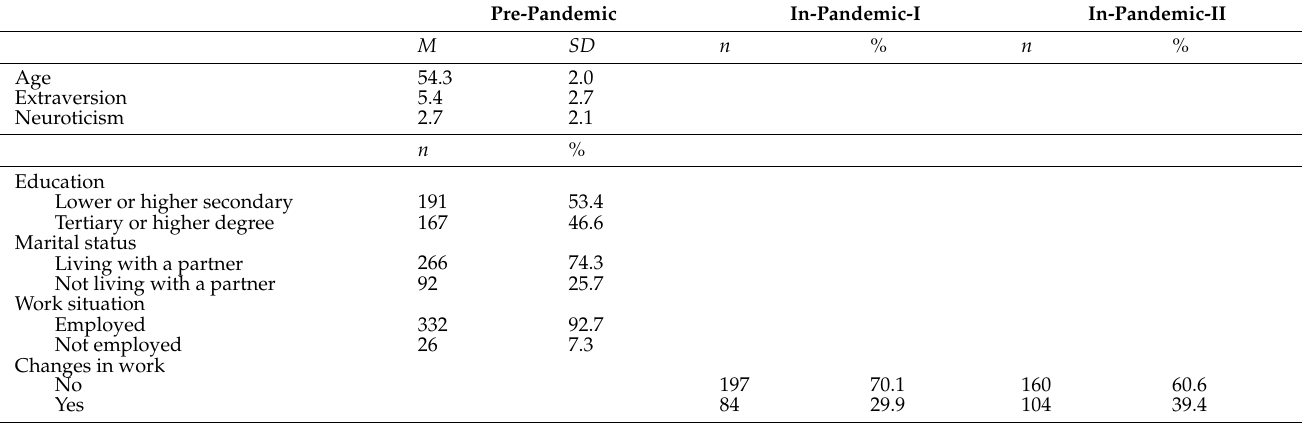
Table 1. Descriptive statistics at pre-pandemic time ( n = 358) and in-pandemic change in work ( n = 281/264). Pre-Pandemic In-Pandemic-I